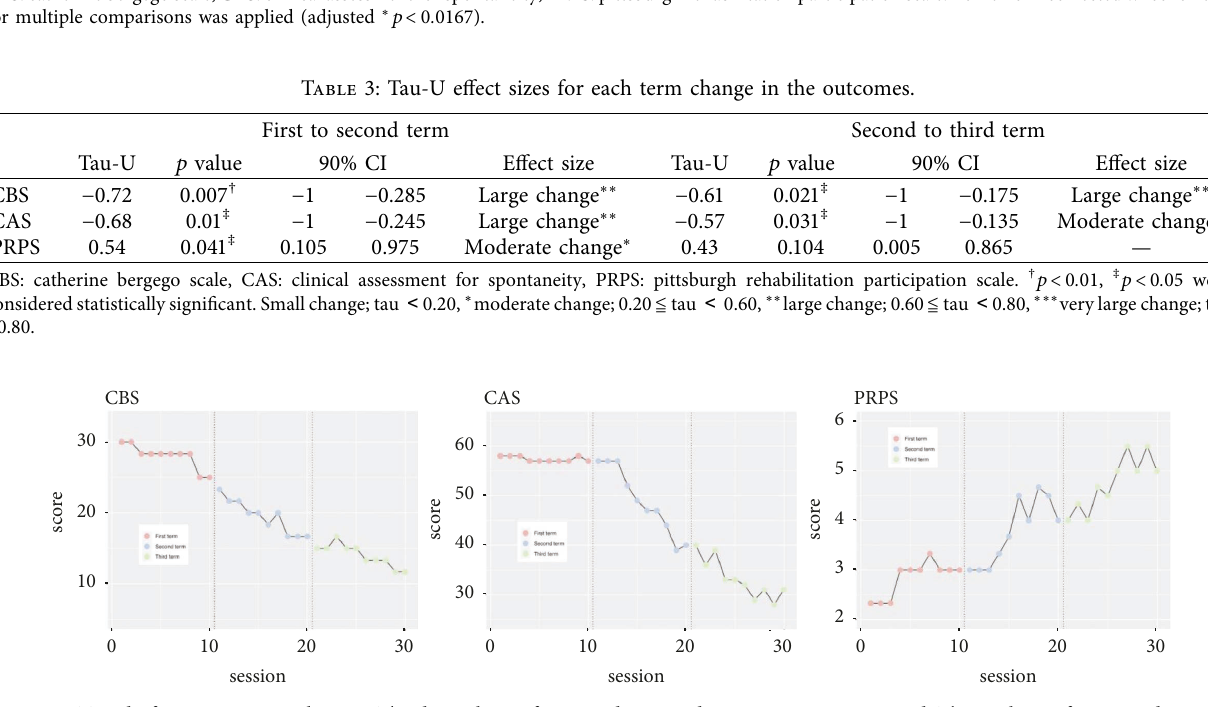
Figure 3: Trend of outcomes in each term. The downslope of CBS and CAS indicate an improving trend. The upslope of PRPS indicate an improving trend. CBS: catherine bergego scale, CAS: clinical assessment for spontaneity, and PRPS: pittsburgh rehabilitation participation scale. Table 4: Correlation analysis between the